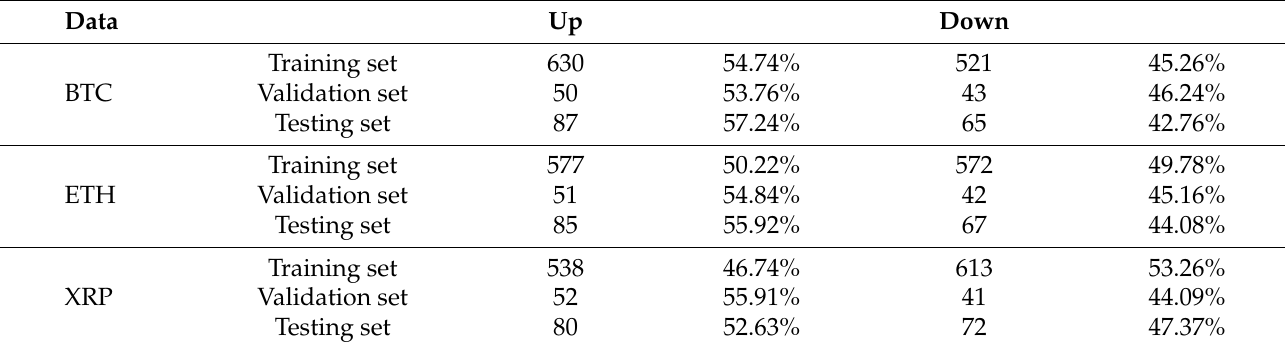
Table 2. The number of up and down movements of BTC, ETH, and XRP data.